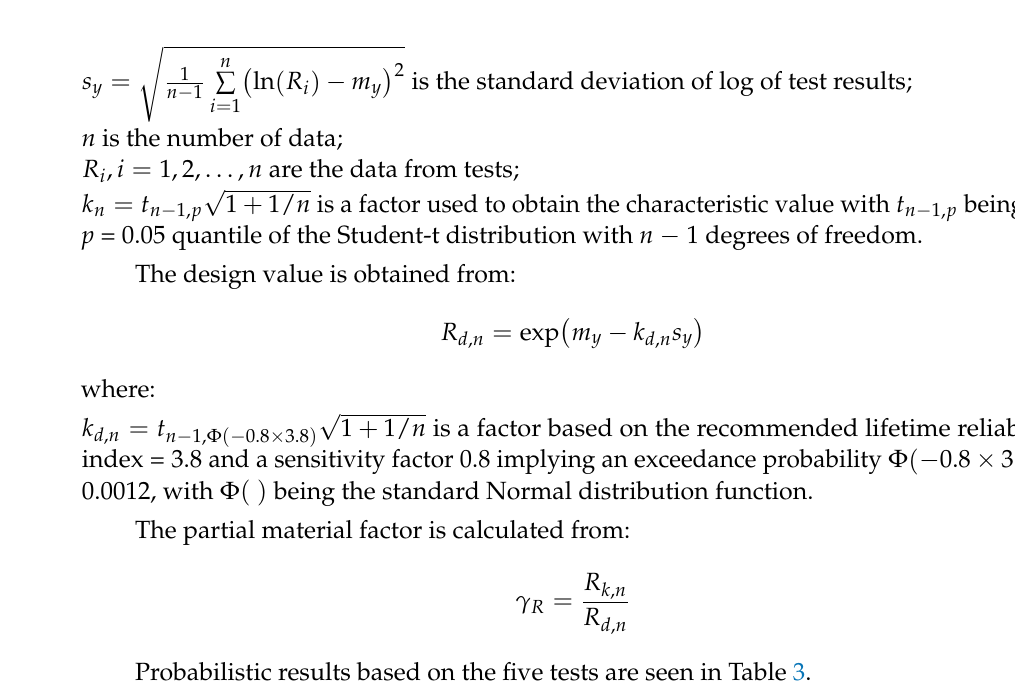
Table 3. Probabilistic results, including design resistance and partial factor. Mean